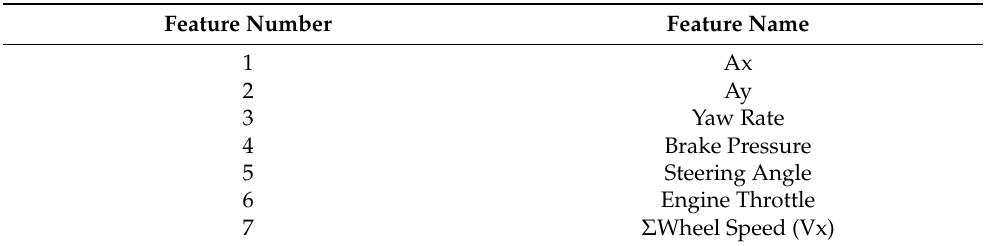
Figure A1. Result of feature importance weight analysis. Table A1. Feature name of each number.